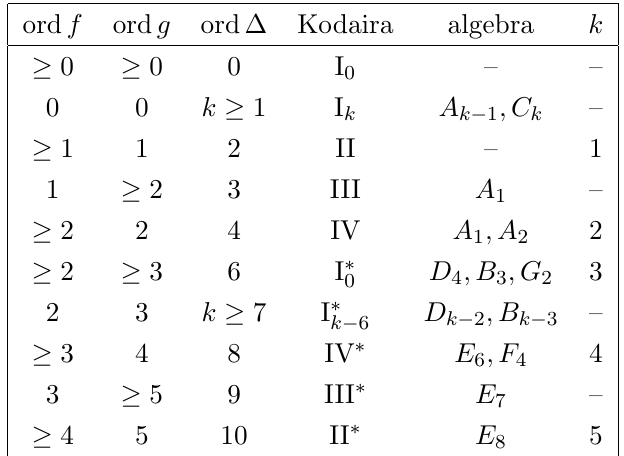
Table 1. Kodaira classi(cid:12)cation of singularities. The corresponding 7-branes supports the algebra, depending on further splitting or monodromy conditions